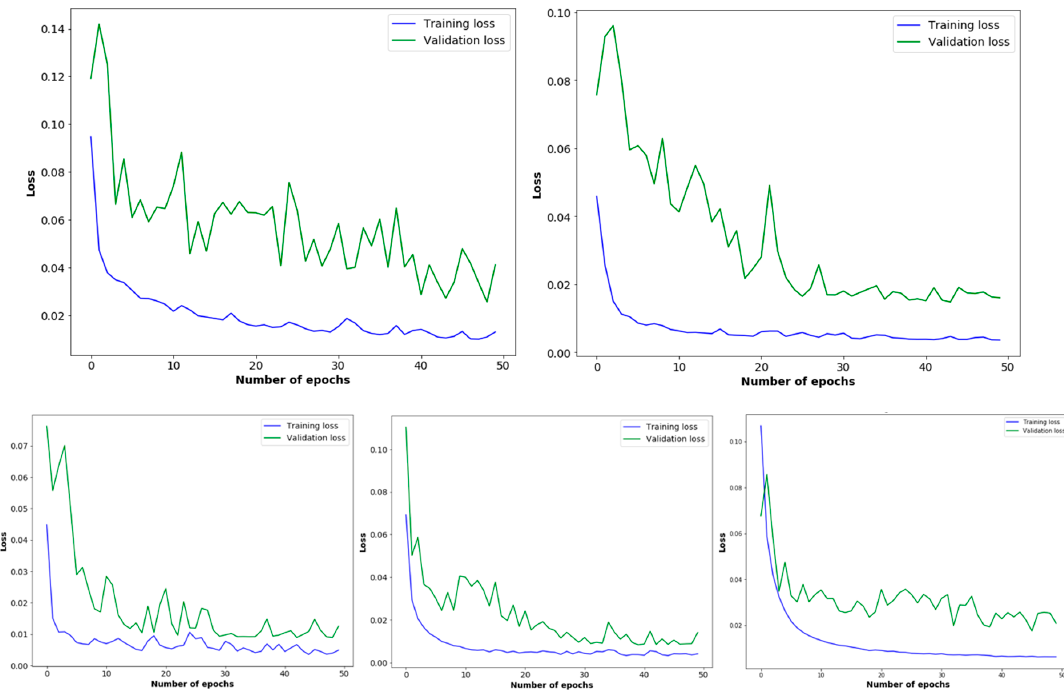
Figure 5. Training and validation loss for simple neural network (NN) (top left), LSTM with dropout (top right), GRU (bottom left), GRU with a recurrent dropout (bottom middle), and GRU with dropout and recurrent dropout (bottom right). Table 3. Train test RMSE for GRU recurrent model.